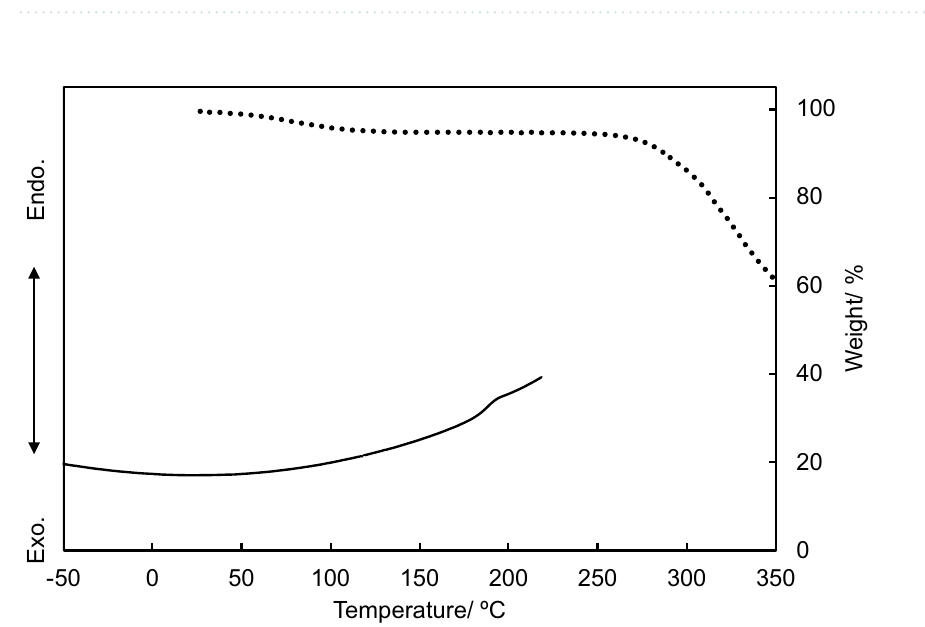
Figure 2. Thermogravimetric analysis (dotted line) and differential scanning calorimetry (solid line) thermograms of